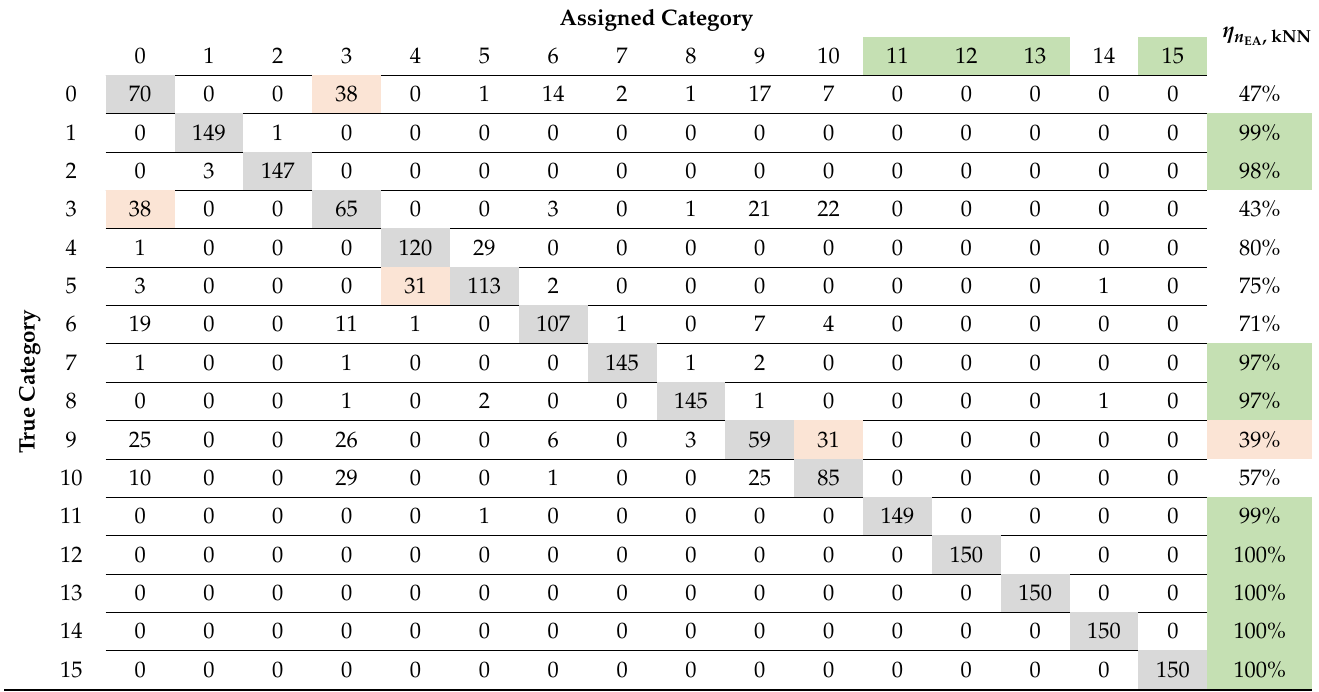
Table 6. Confusion matrix and classification accuracy for the k-nearest neighbors